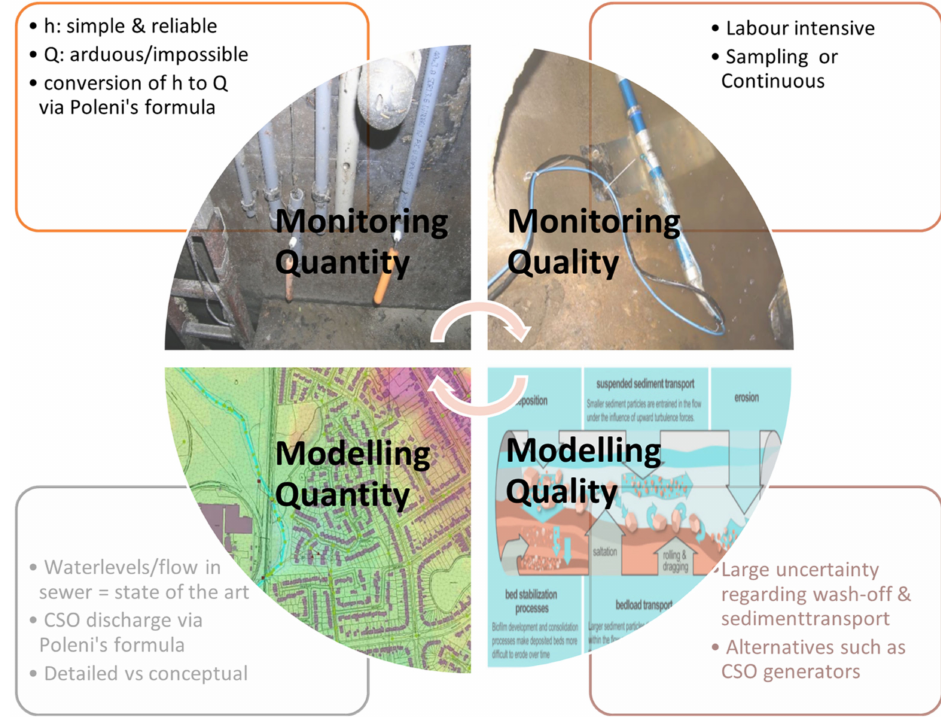
Figure 1. Potential ways to quantify CSO emissions as a circle with four quadrants with monitoring aspects on top, modeling aspects at the bottom, quantitative features on the left, and qualitative features on the